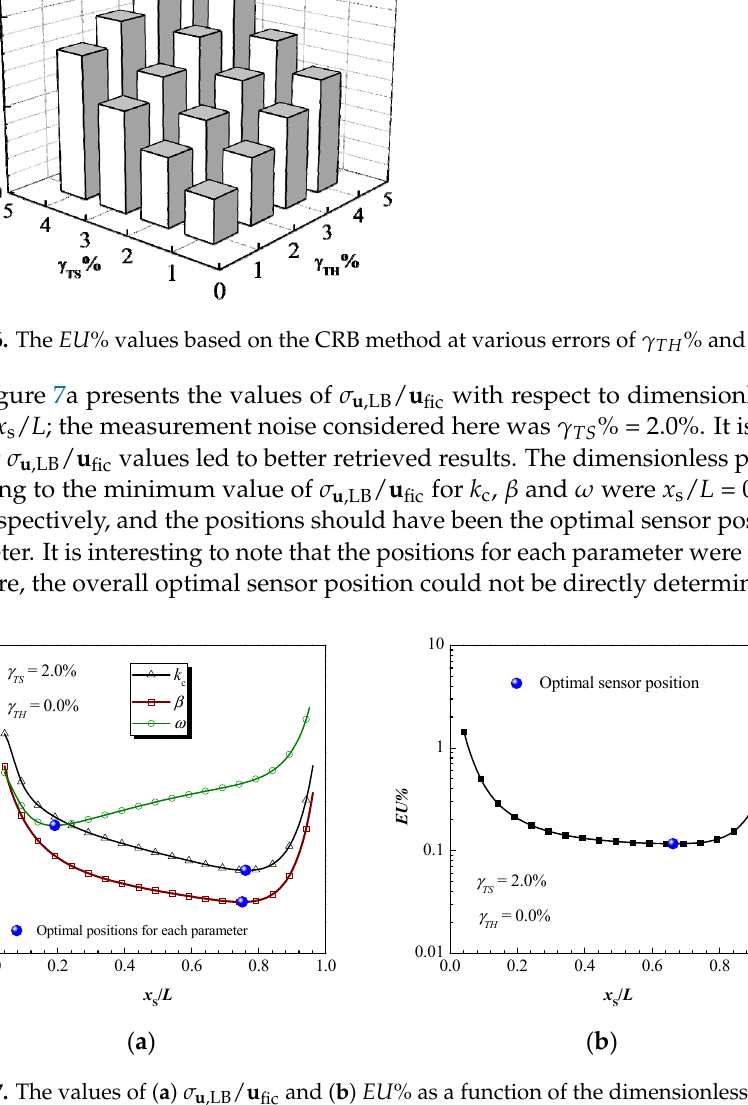
for γ TS % = 2.0% and γ TH % = 0.0%.